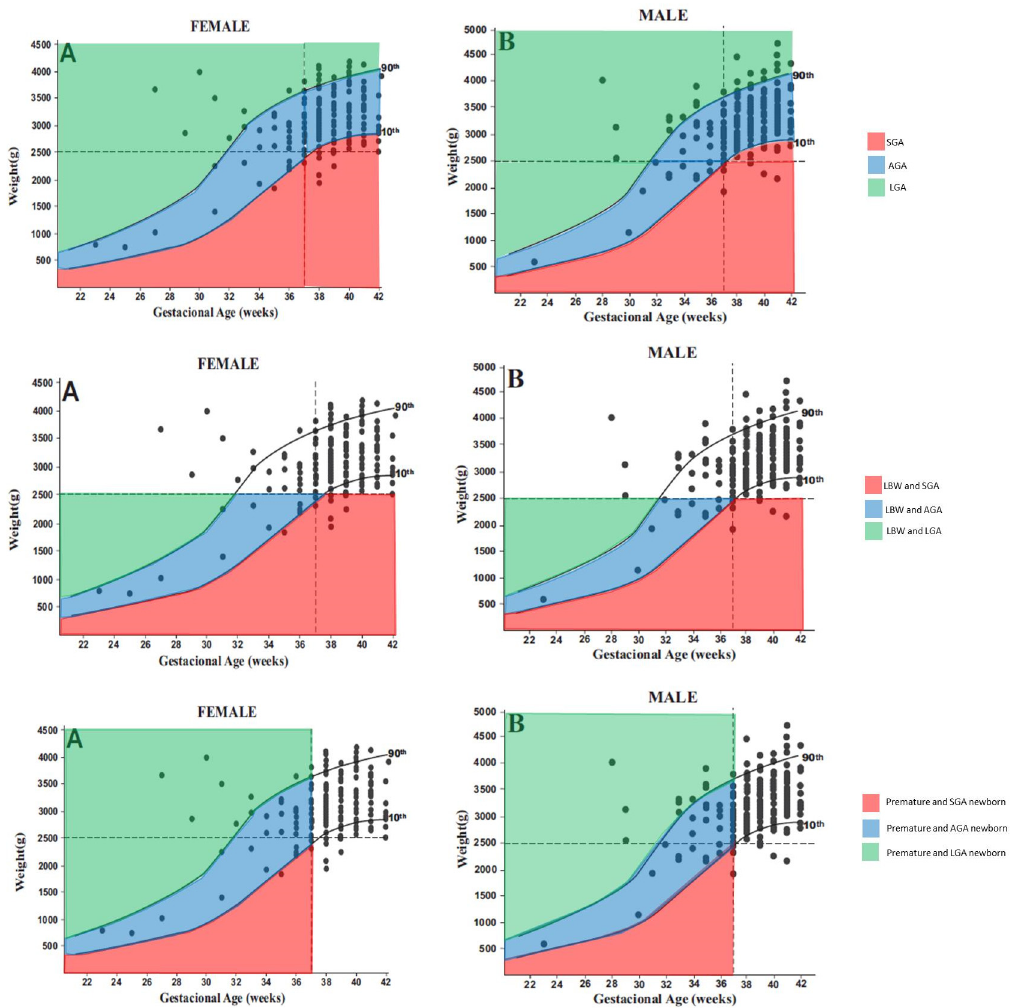
Fig 2. Correlation between gestational age and birth weight and graphical representation of the 10th and 90th percentiles for females (A) and males (B) based on Brazilian-specific growth curves. SGA: Small for gestational age ( < 10th percentile); AGA: Appropriate for gestational age (10th-90th percentile); LGA: Large for gestational age ( > 90th percentile); LBW: Low birth weight ( < 2500 g); Premature newborn ( < 37 weeks). The intra-uterine growth retardation (IUGR) was defined as the newborn SGA. No differences were found by gender to IUGR (p = 0.686), LBW (p = 0.406) and prematurity (p =